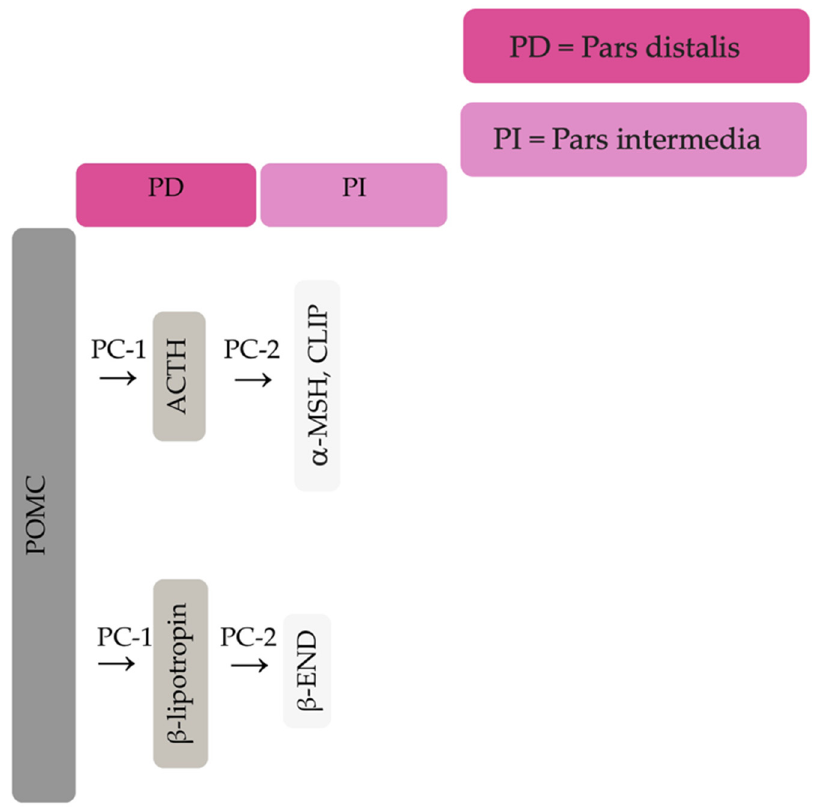
Figure 1. Simplified processing of POMC in the pars distalis by PC-1 to produce ACTH and β -lipo- tropin. Further PC-2 activity on ACTH and β -lipotropin to produce α -MSH, CLIP and β -END in the pars intermedia.